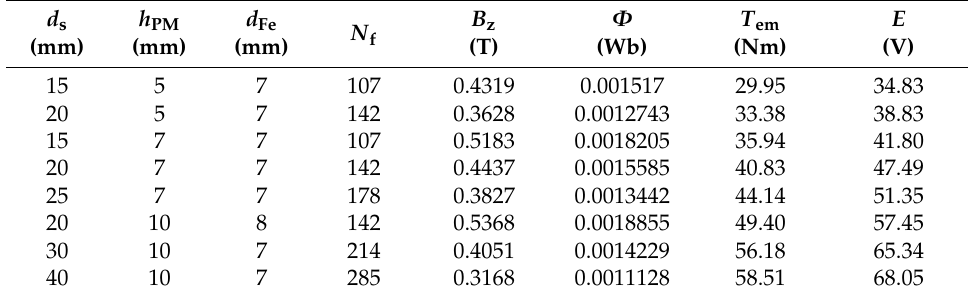
Table 4. Design of 10 pole AFPMSM using an analytical method and mathematical models.